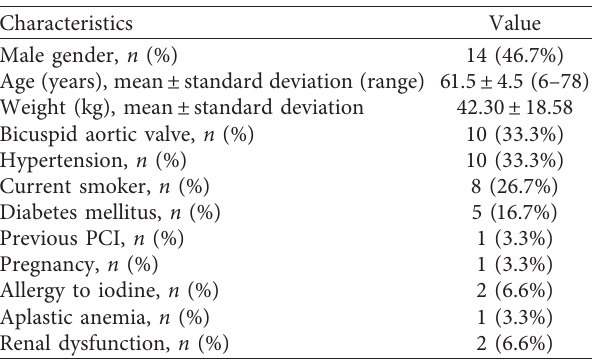
Table 1: Baseline characteristics.